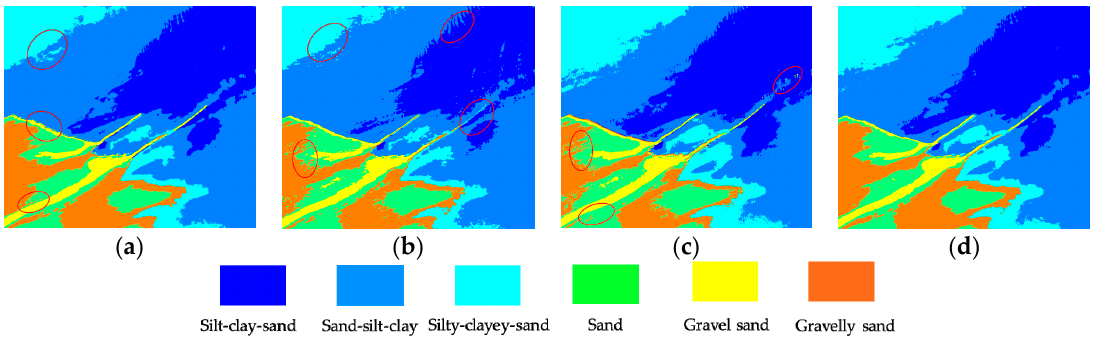
Figure 8. Image classification results of various feature extraction approaches in the Z2 area: ( a ) Gabor, ( b ) CNN, ( c ) SAE, and ( d ) SDAE.